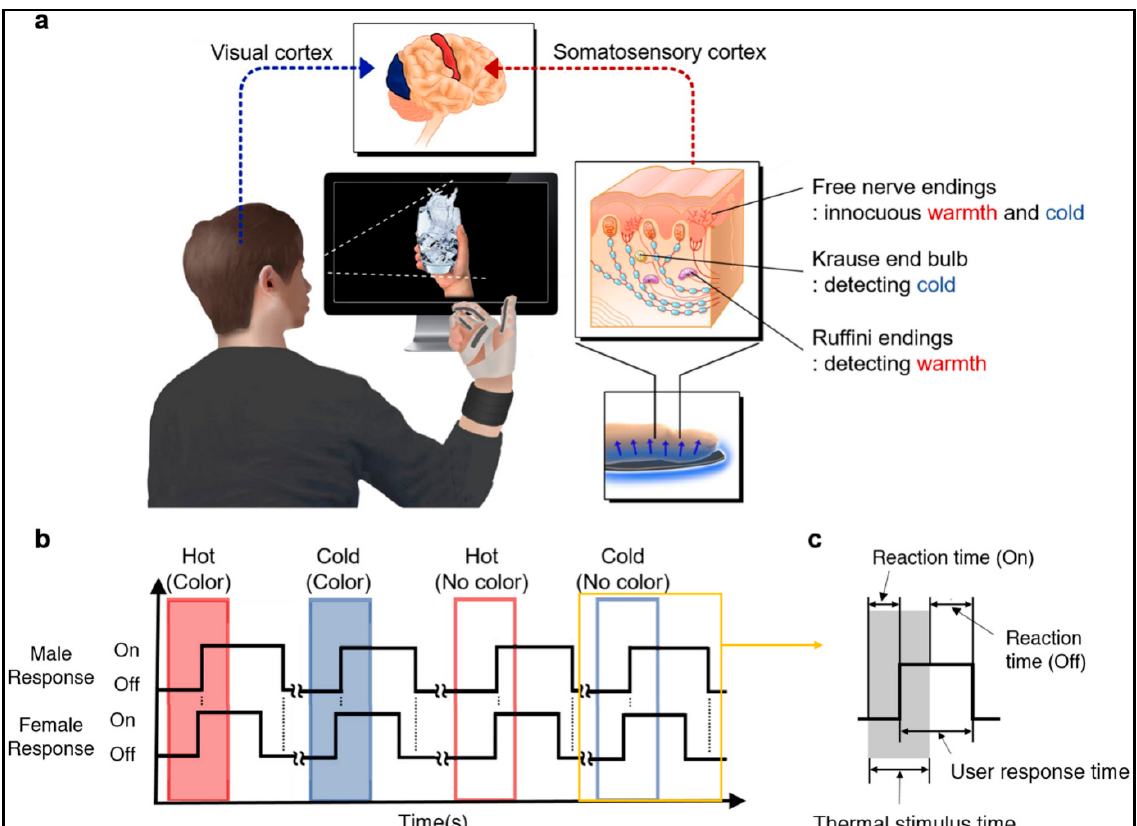
Figure 10. Thermal display glove for interacting with virtual reality. ( a ) Illustration of the operation of thermal display glove system, ( b ) Response time to the thermal and color stimuli in the user test.